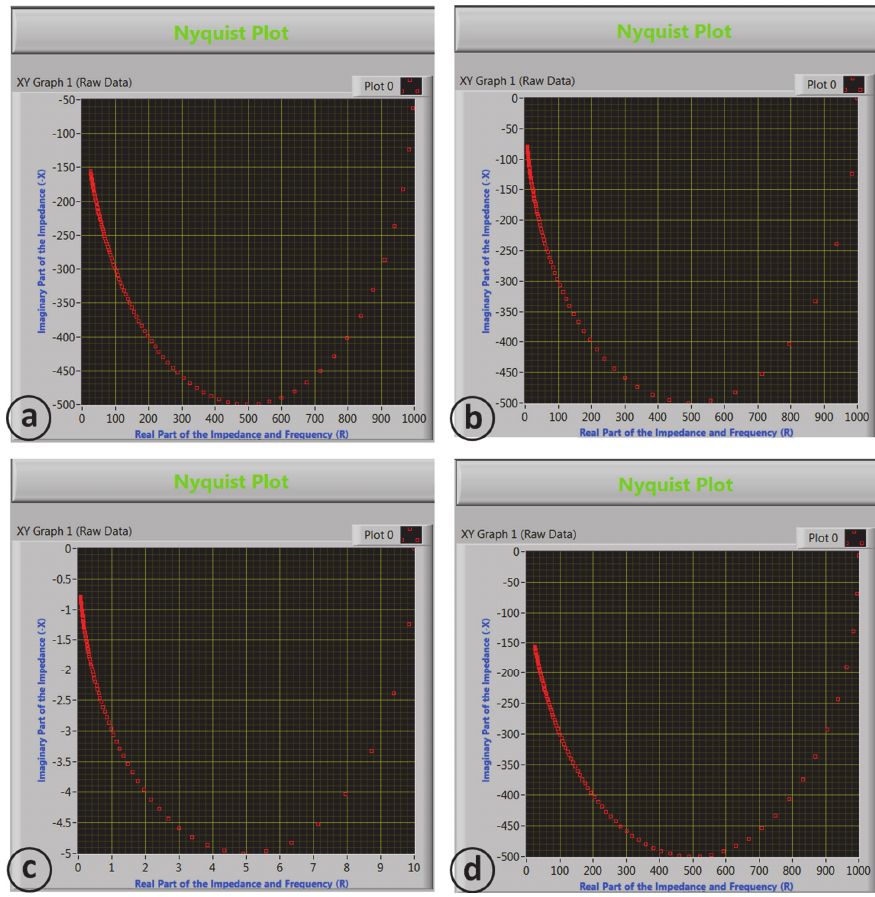
Fig.11: Nyquist plots of simulated impedance data loaded in the GUI of